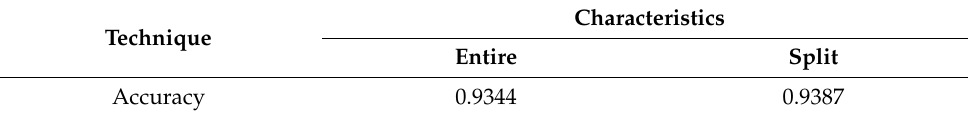
Table 4. Transfer diverse characteristics to the layout for comparison.